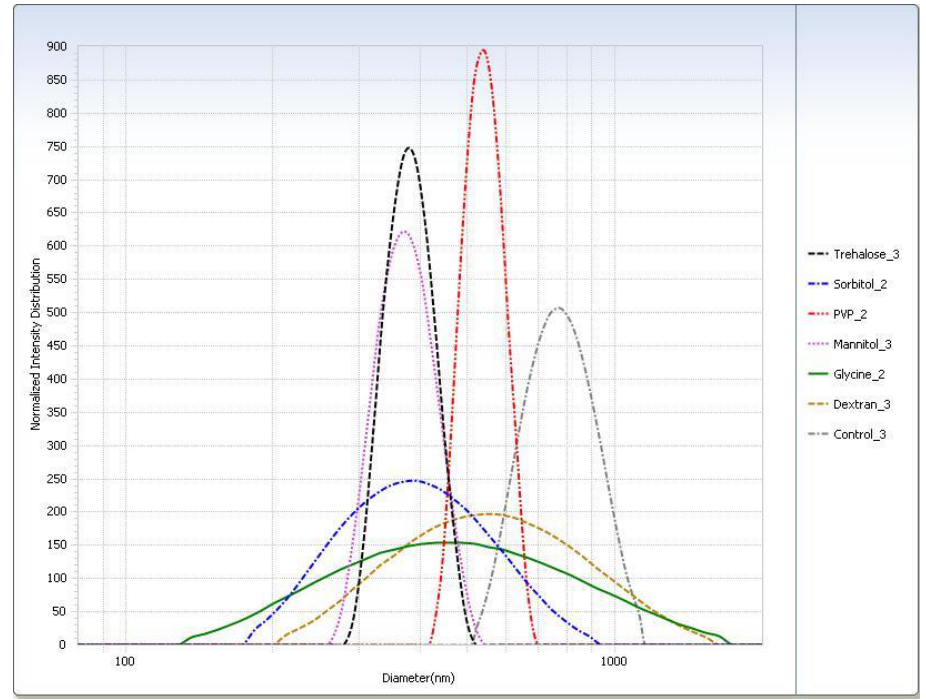
Figure 4. Intensity distribution of cryoprotected SA-P SLNs after freeze–thaw study at the − 20 ◦ C (slow freeze) condition.